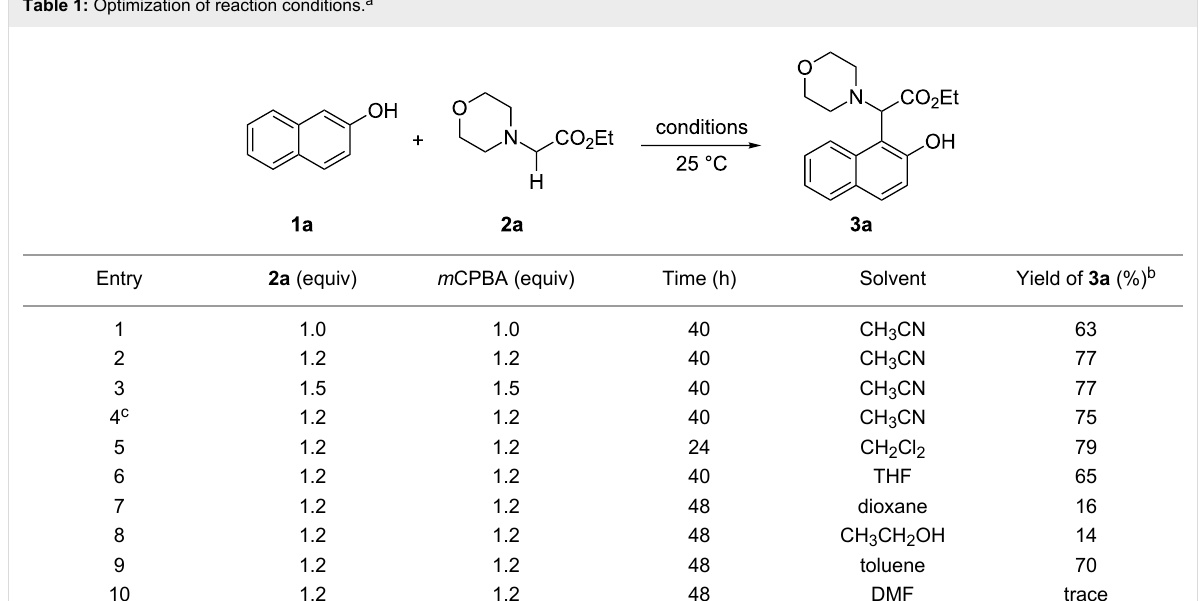
Table 1: Optimization of reaction conditions. a